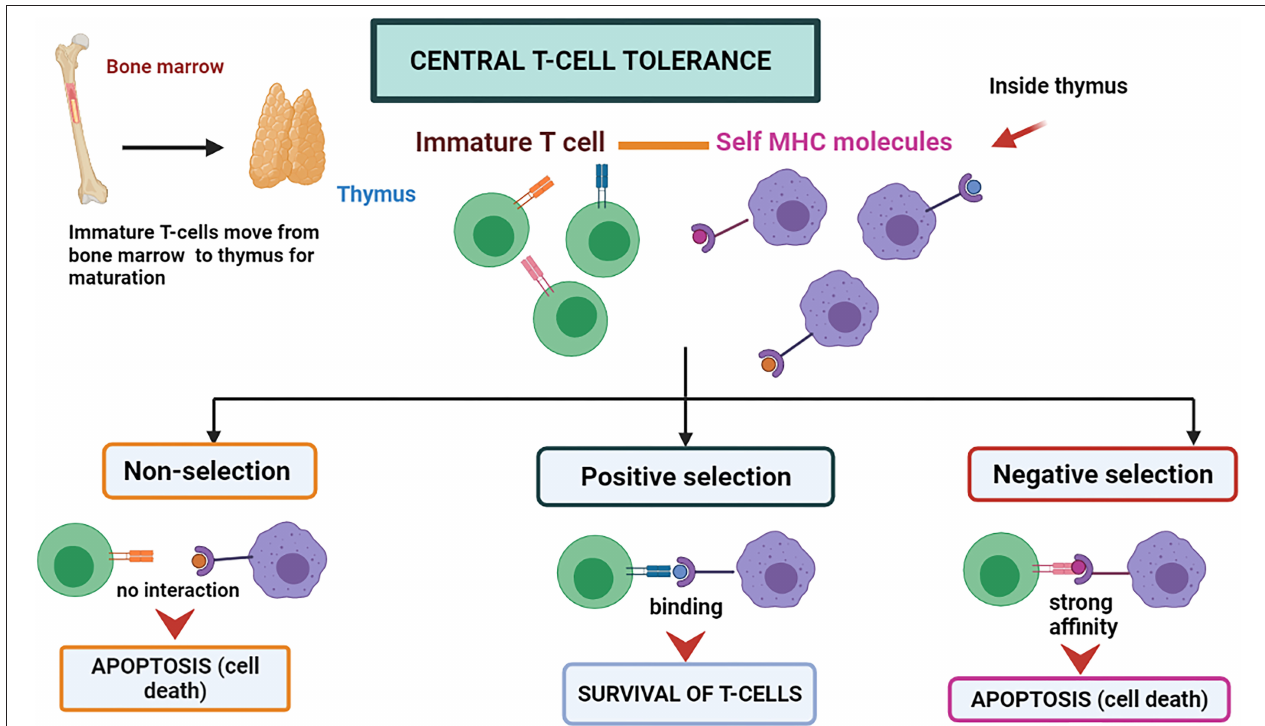
FIGURE 1 | Central T-cell tolerance mechanism. The T-cells mature in the thymus by attaching themselves to self MHC molecules. If the interaction is not strong, the T-cell survives called “positive selection.” If the interaction is too strong, it leads to programmed cell death called “negative